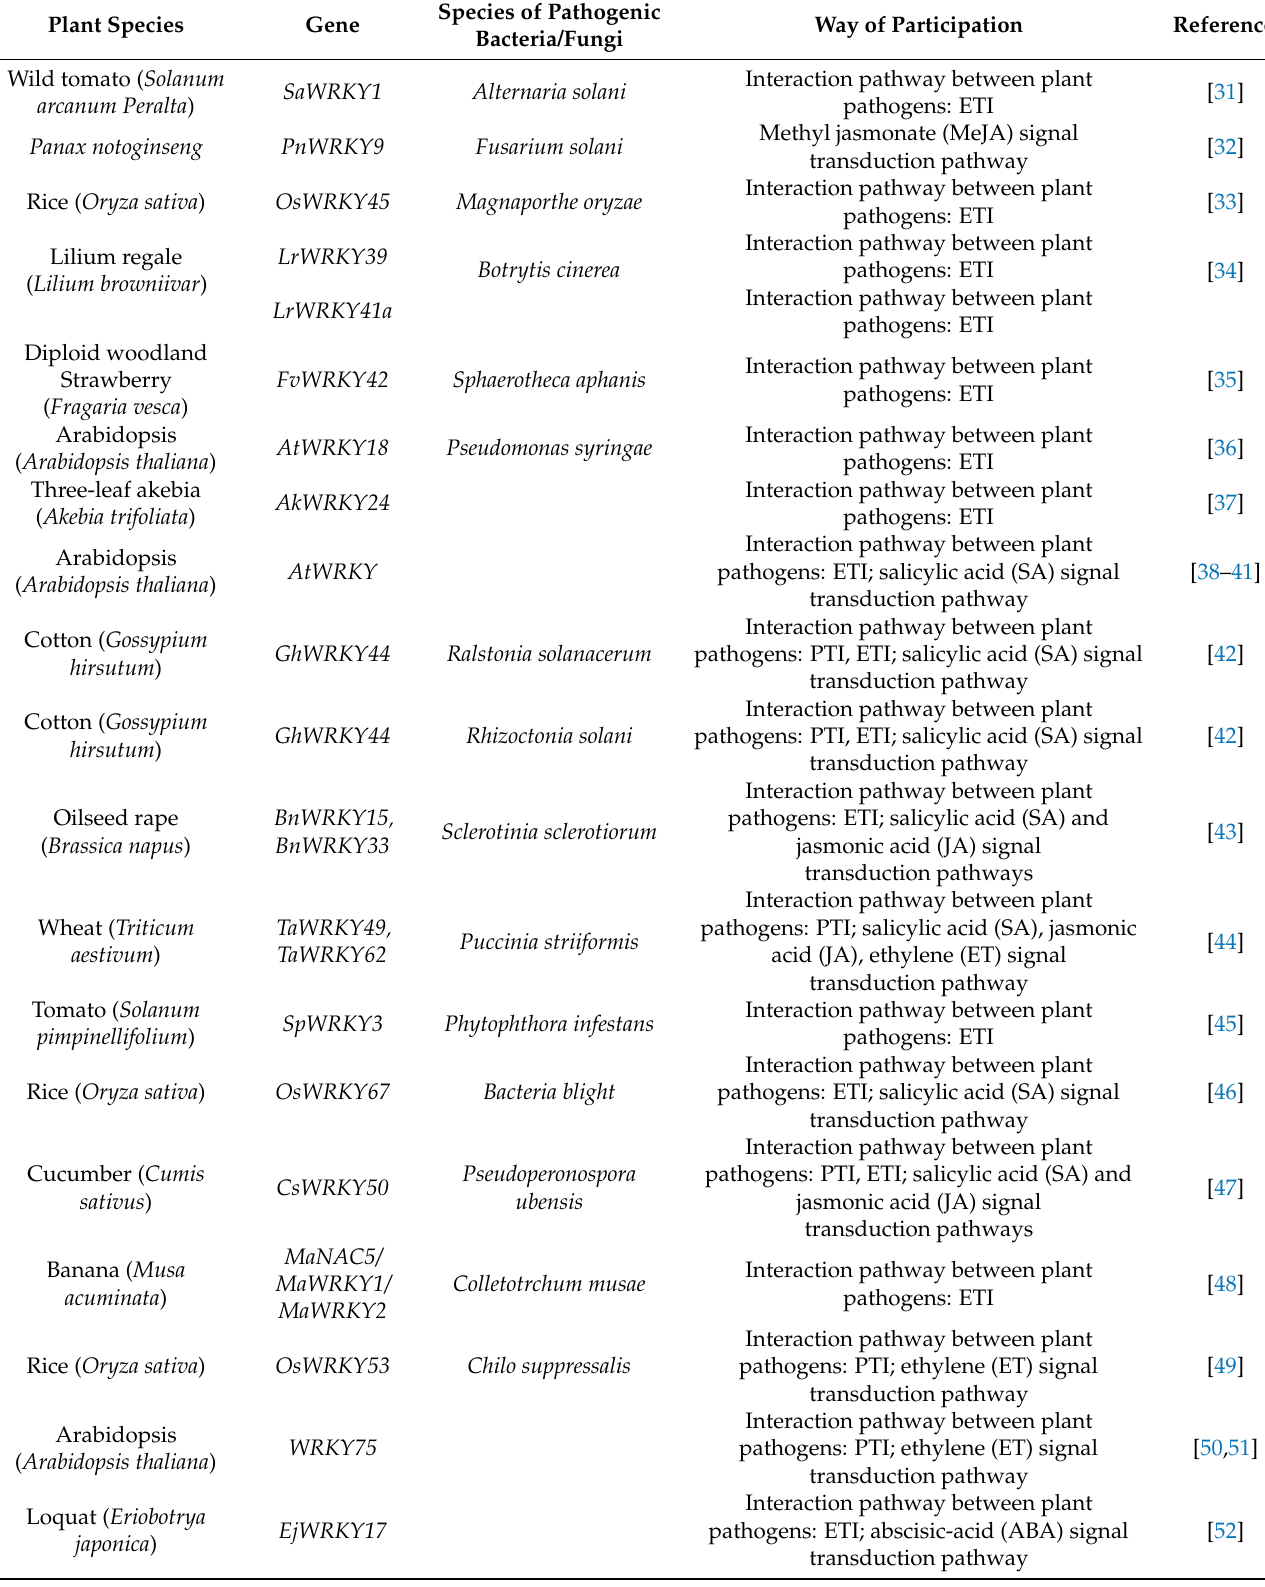
Table 1. Regulation of WRKY transcription factors in biotic stress